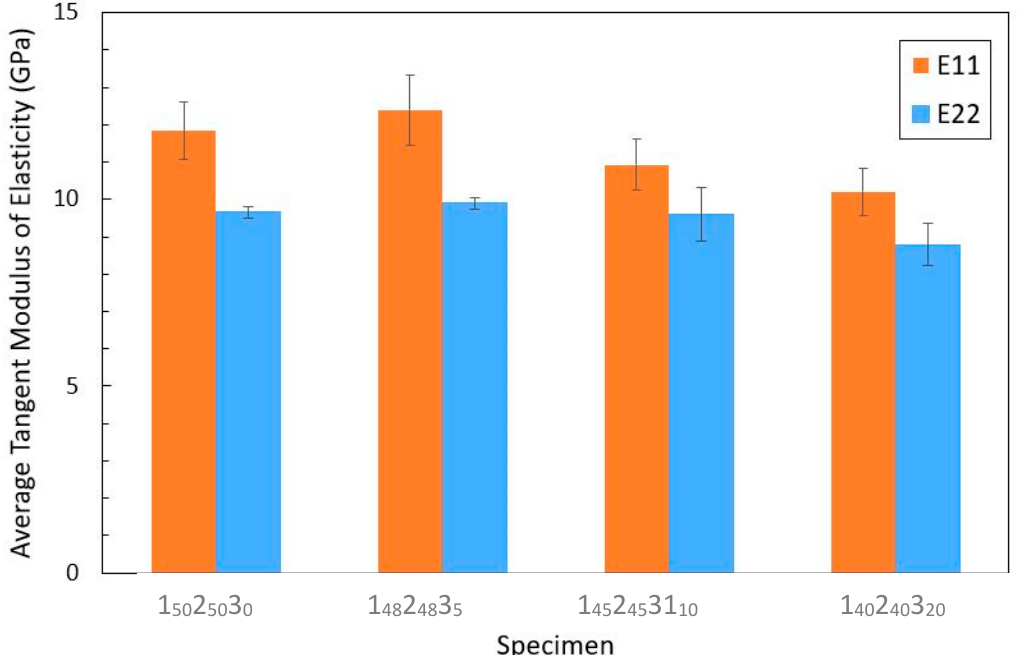
Figure 6. Graphs displaying the variation in the E 11 and E 22 flexural moduli of the samples as a function of POSS content.